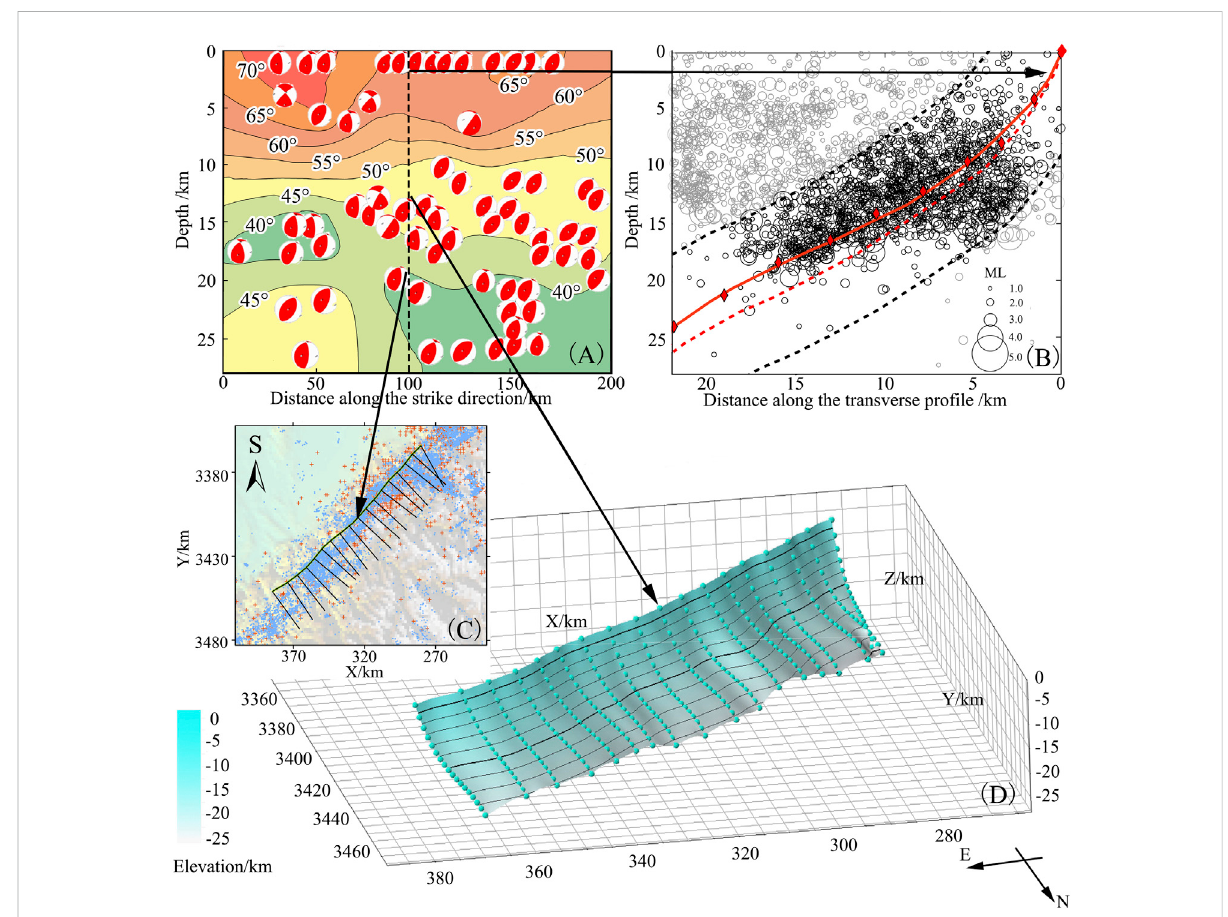
FIGURE 3 Three-dimensional modeling process for subsurface geometry taking the middle segment of the Yingxiu-Beichuan Fault as an example. (A) Fault dip variations according to the focal mechanism solutions; (B – C) Fine model of fault geometry along pro fi le by fi tting the selected and relocated hypocenters; (D) 3D model of the fault